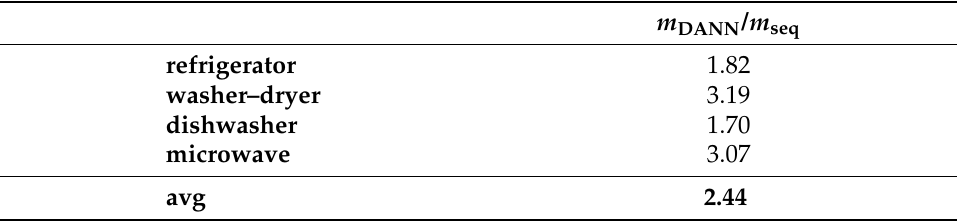
Table 10. Ratio of DANN and seq2point normalized training time given the number of train- ing